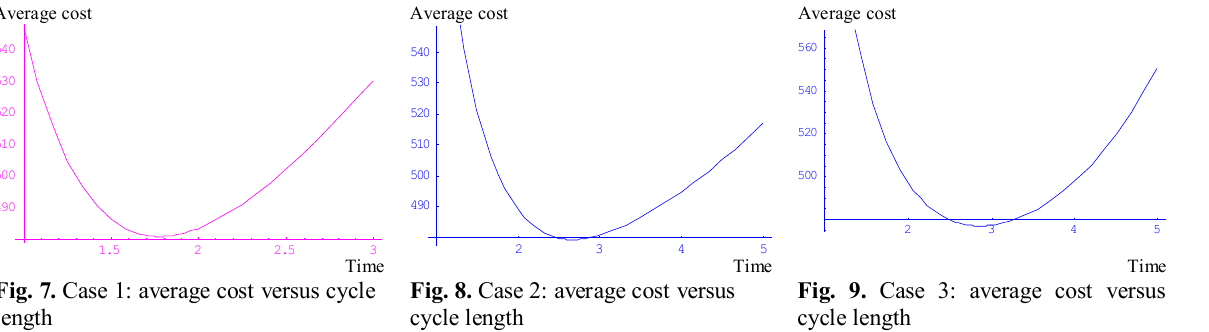
Fig. 7. Case 1: average cost versus cycle Fig. 8. Case 2: average cost versus Fig. 9. Case 3: average cost versus